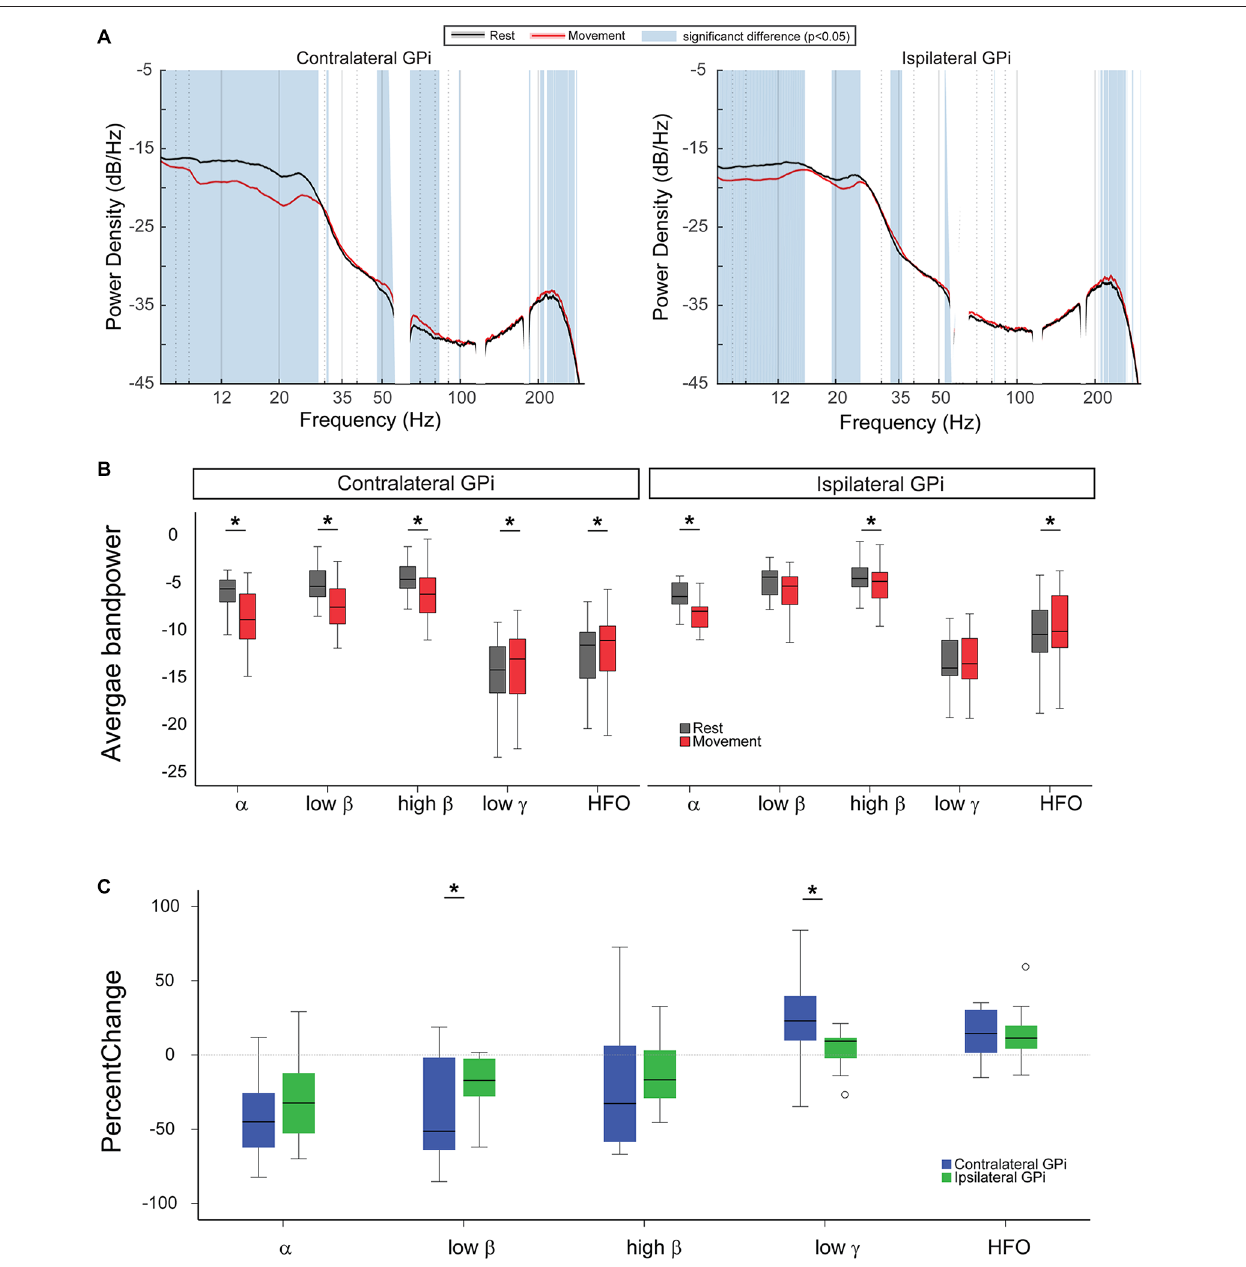
FIGURE 1 | Unilateral hand movement modulates oscillatory power in bilateral Globus Pallidus interna (GPi). (A) Average power spectral densities across the cohort during rest (black curve) and unilateral finger tapping (red curve). Blue vertical shade indicates significant difference between resting and movement conditions as tested by two-group test of spectra and corrected for multiple comparisons. (B) Comparing average power for different frequency bands between rest (gray) and movement (red). (C) Comparison of percent change in the spectral power between the two GPi ipsilateral (green) and contralateral (blue) to the moving body side ((Power during movement − Power during rest)/Power during rest × 100). In panels (B,C) , asterisk signs ( ∗ ) indicate statistical significance of the difference between the two conditions as tested by paired t -test and corrected for multiple comparisons ( P < 0.05).